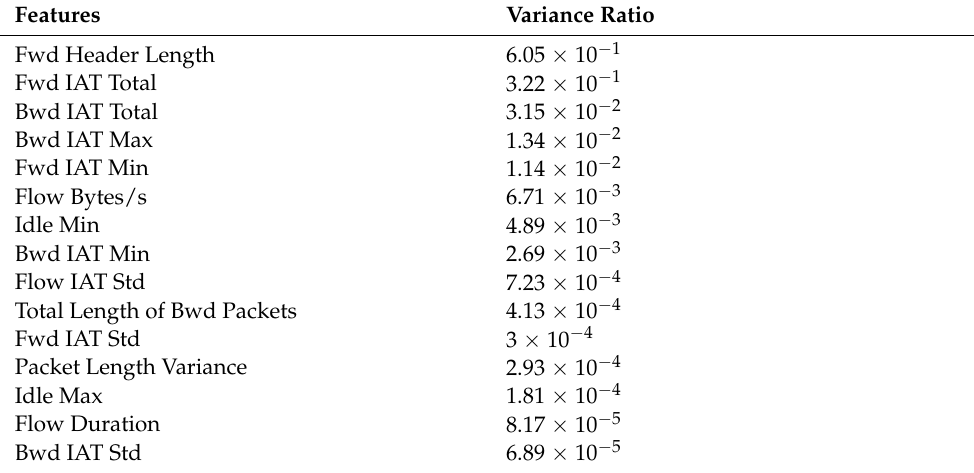
Table 5. Dataset Discriminative